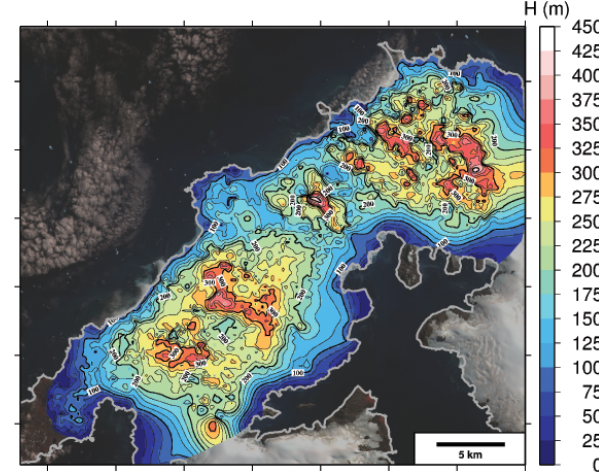
Figure 4. Interpolated ice thickness distribution H in m on King George Island (the contour line interval is 25m). The grey thick line shows the coastline. Database: compilation of the ground based survey (taken from Blindow et al., 2010) and the airborne measure- ments. Background image is a © SPOT Image from